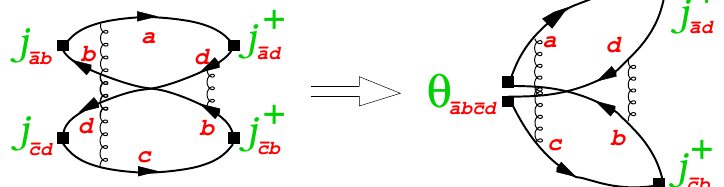
Figure 4. Definitely flavor-exotic four-current correlation function (7) of flavor- rearranging type ( left ) and ( right ) contraction (9) to a correlation function of one tetraquark interpolating operator (6) and two quark-bilinear currents (5) [31]: typical contribution of lowest tetraquark-phile perturbative order O ( α 2 s )